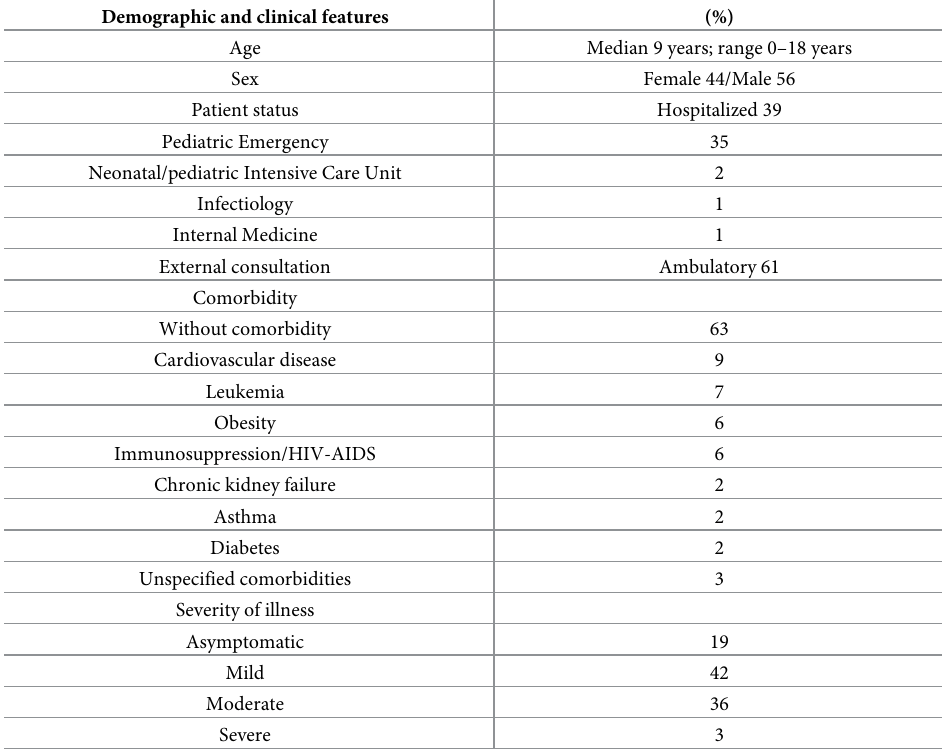
Table 1. Demographic and clinical features of 100 Mexican children and adolescents with